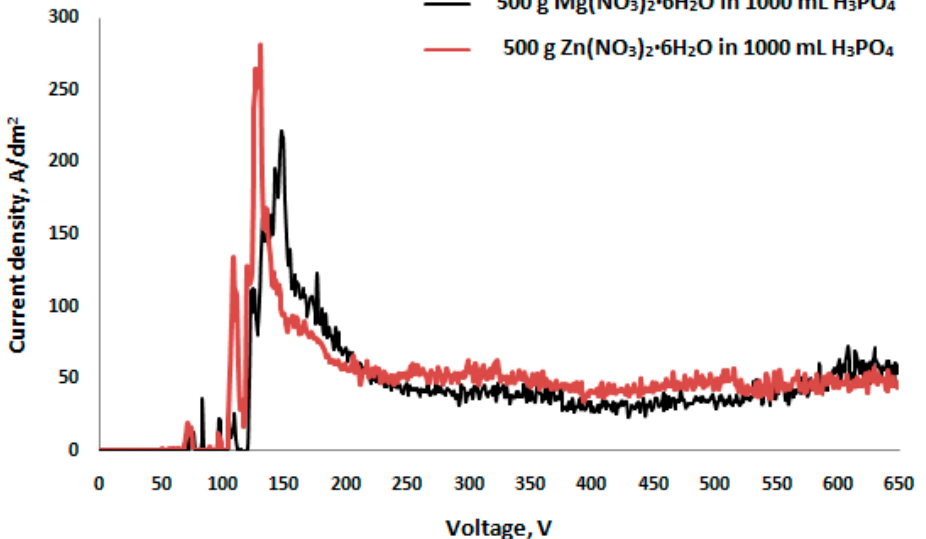
Figure 1. Current vs. voltage curves of CP (commercially pure) Titanium Grade 2 after plasma electrolytic oxidation (PEO) treatment in 500 g Mg(NO 3 ) 2 or 500 g Zn(NO 3 ) 2 in 1000 mL H 3 PO 4 electrolyte.